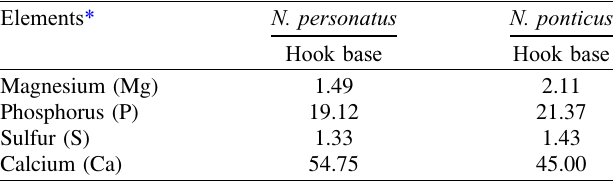
Table 6. Chemical composition of the base of large hooks for Neoechinorhynchus personatus and N. ponticus cut on a longitudinal axis with a Gallium beam (LMIS) from a dual beam